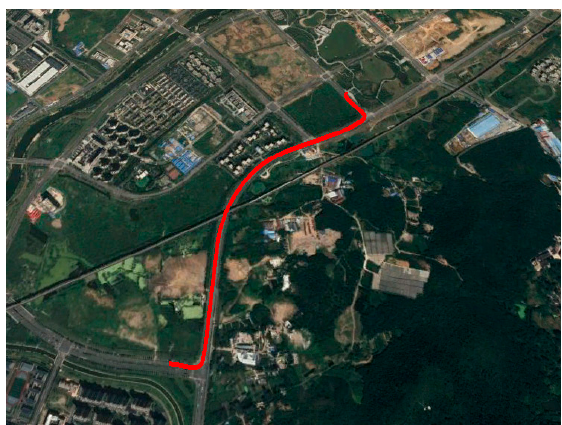
Figure 8. Field test trajectory.